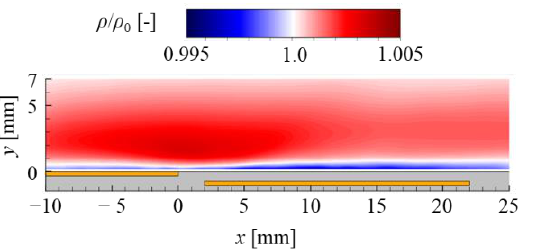
Figure 9. Density field of the plate-PA, obtained from the BOS measurement.